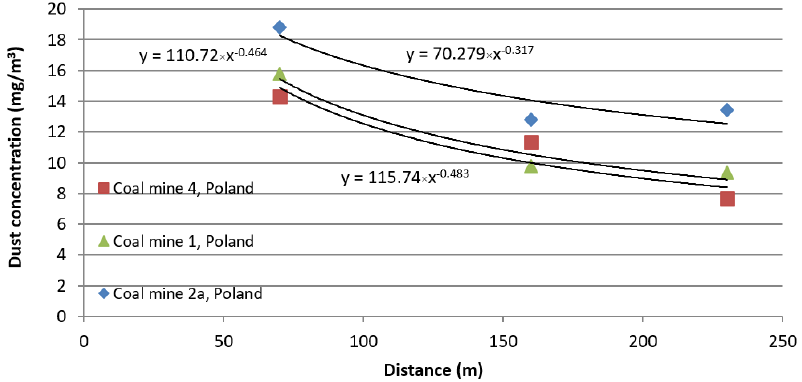
Figure 14. Characteristics of the average distribution of PM10 dust concentration depending on the distance in the gates, based on the results from P ł -2 dust meters with the functions that describe them.